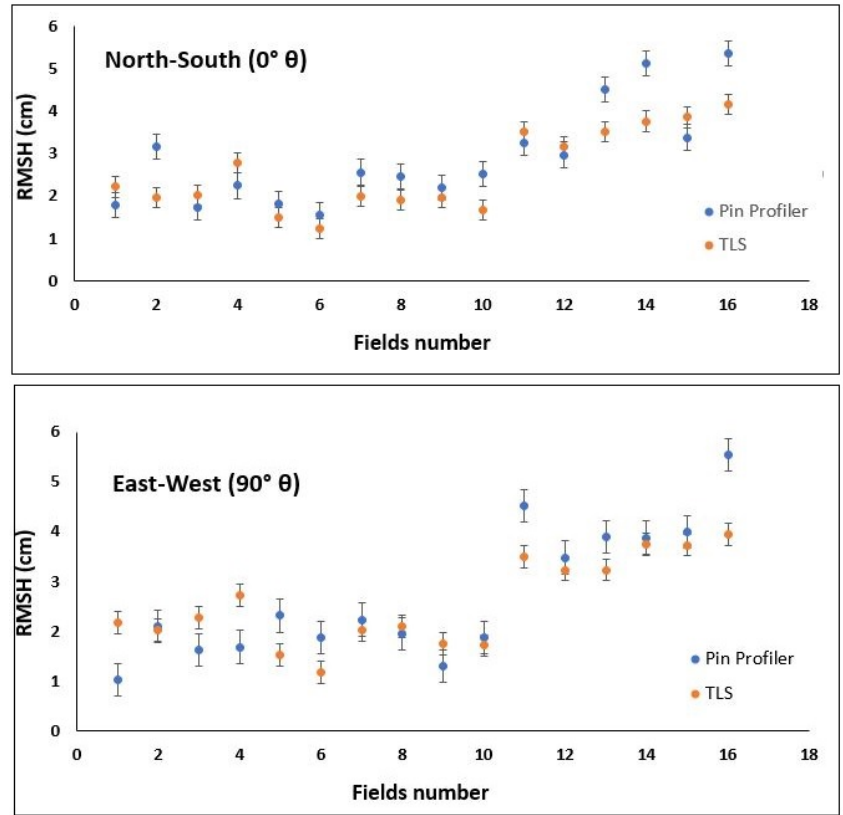
Figure 4. The comparison of mean RMSH measured by TLS and pin profiler at two different orien- tations.